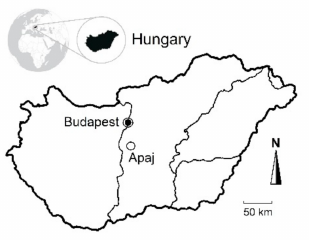
Figure 1. Geographic position of Apaj on the map of Hungary.